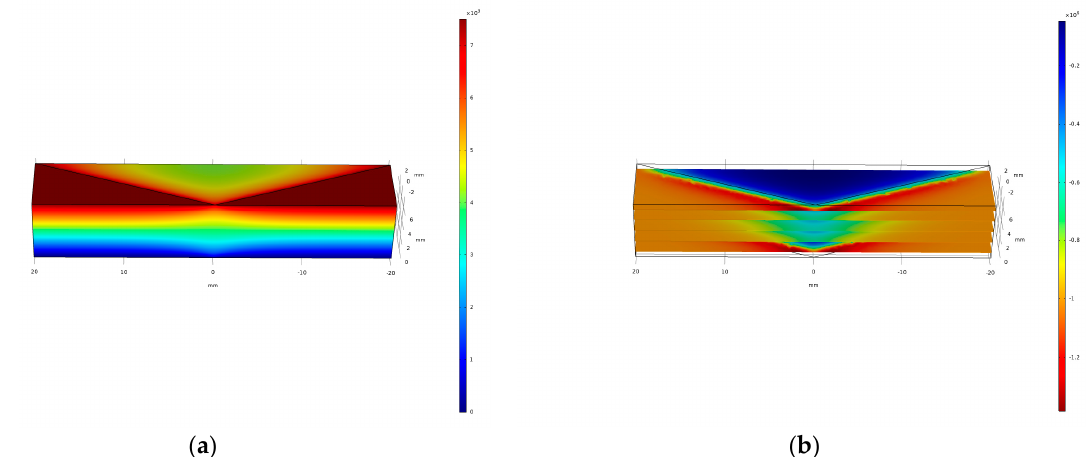
Figure 20. ( a ) Voltage ( b ) electric field (E z ) simulation of the EO steerer based on PMN-PT ceramic under 1 kV/mm at 25 ° C using a COMSOL model.